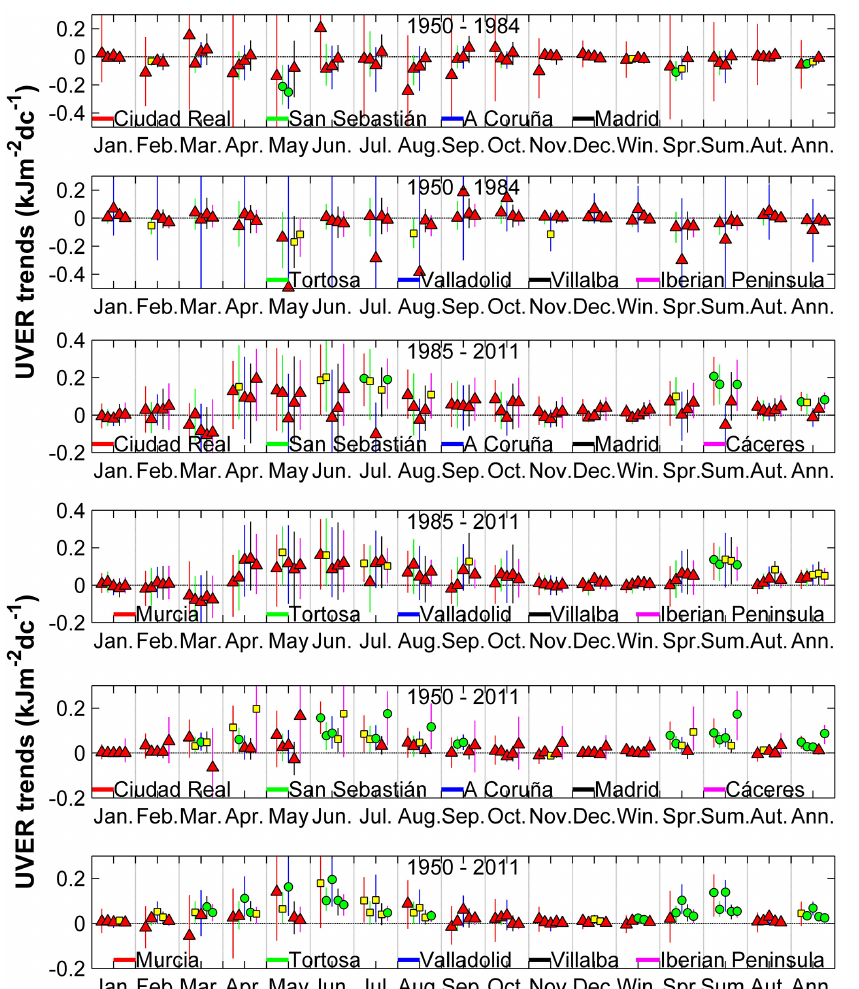
Figure 5. UVER trends for different months and seasons, and for annual and three periods. The error bars are the 95% confidence interval and their colour represents the location of the legend. The green circles represent statistically significant trends with 99% confidence ( p <0.01), yellow squares represent statistically significant trends with 95% confidence ( p <0.05), and red triangles represent non-statistically signifi- cant trends with at least 95%